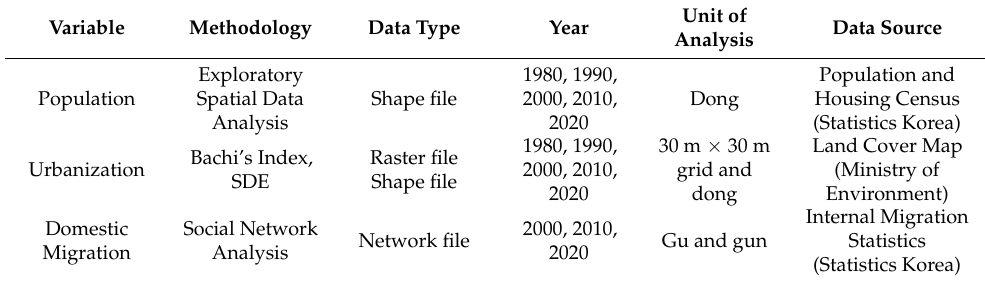
Table 1. Data and unit of